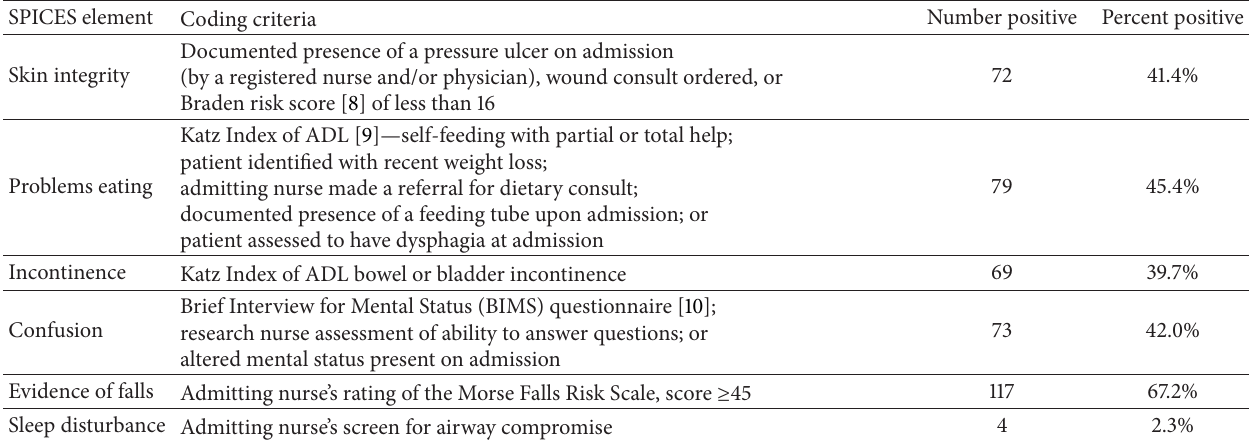
Table 1: Description of SPICES scoring criteria and numbers positive in the sample ( N = 174).